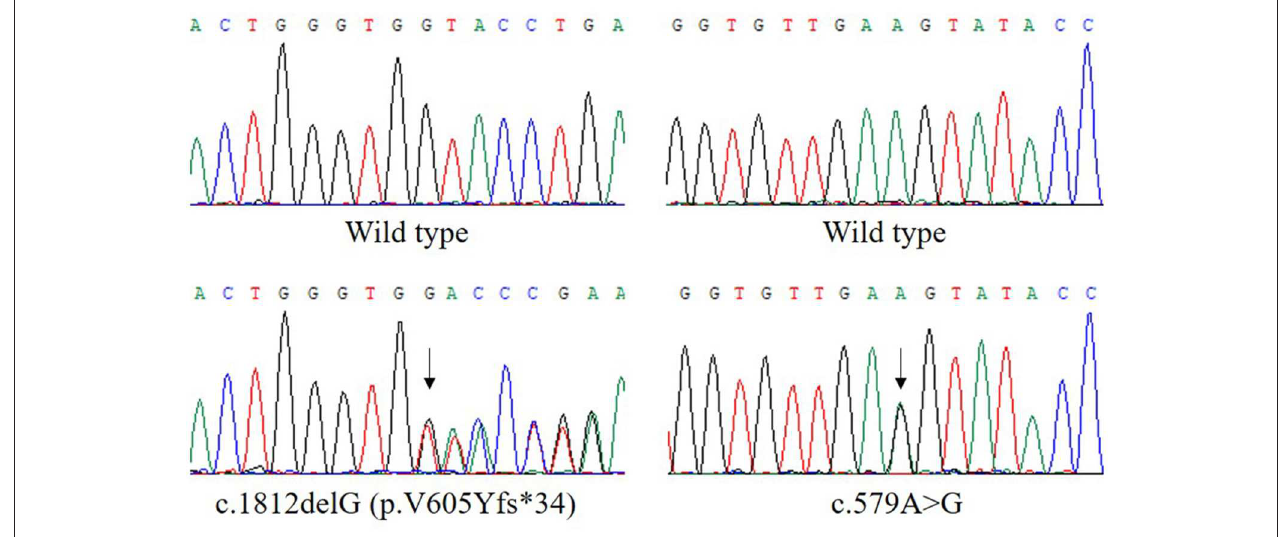
FIGURE 1 | The compound heterozygous variants in the ETFDH gene detected in our patient. The two variants, c.1812delG (p.V605Yfs*34) and c.579A > G, were inherited from her mother and father, respectively. The reference transcript is NM_004453.